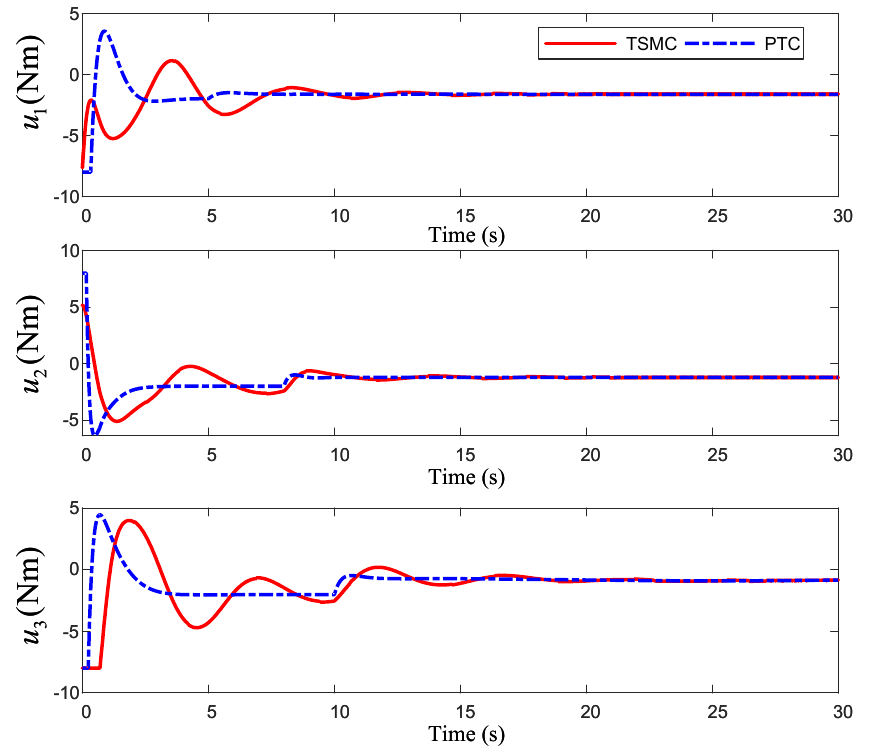
Figure 7. The response of actuator